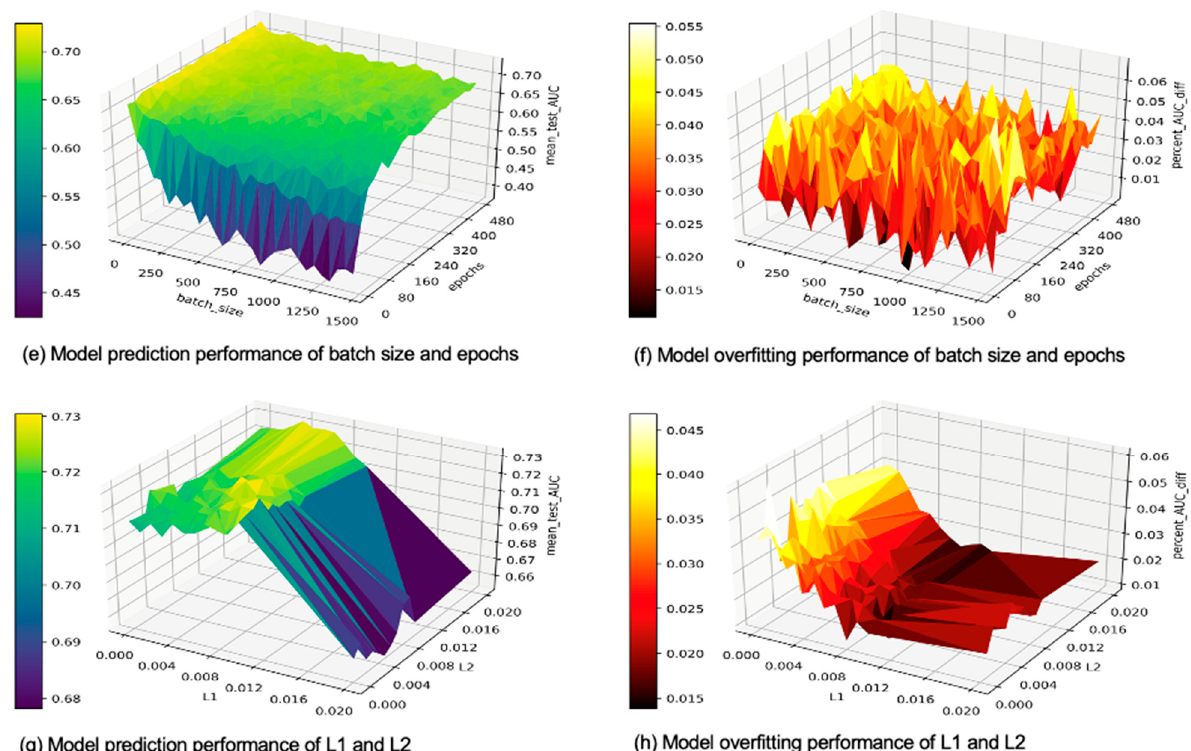
Figure 8. Results of the interactive experiments with hyperparameter pairs.